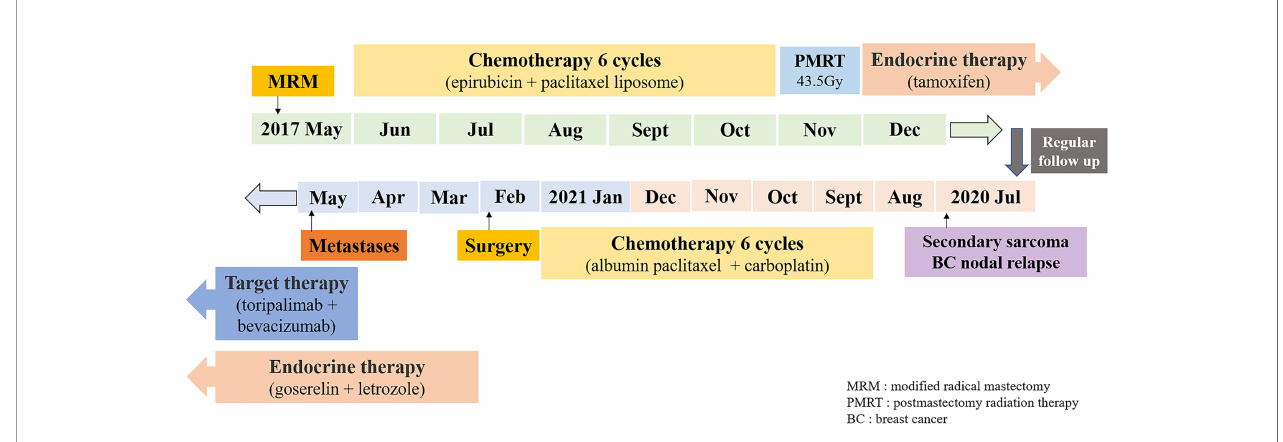
FIGURE 3 | Timeline of historical and current treatments.